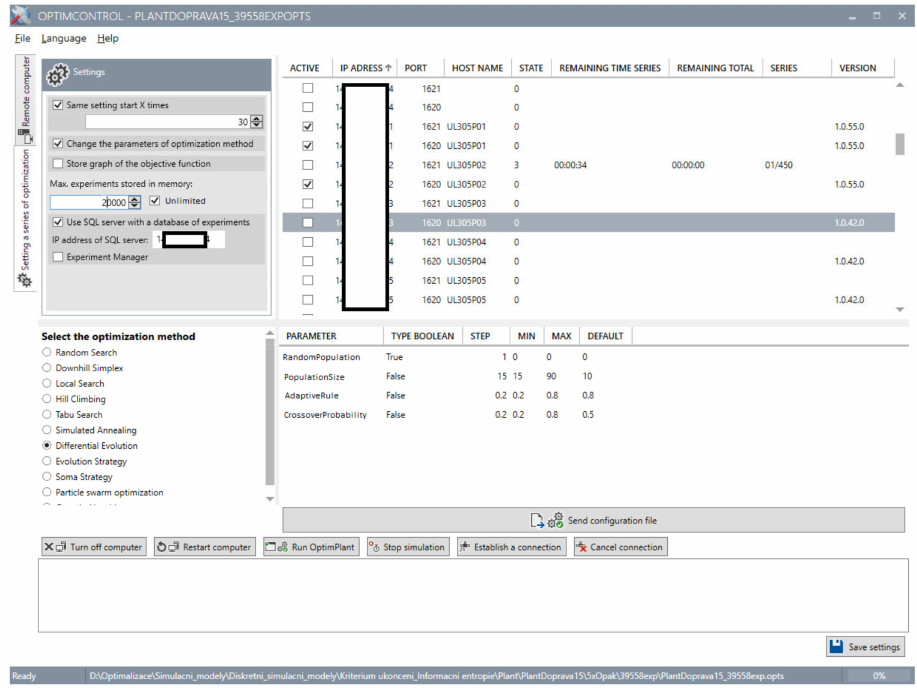
Figure 8. Client application GUI—remote control of simulation optimiser running on